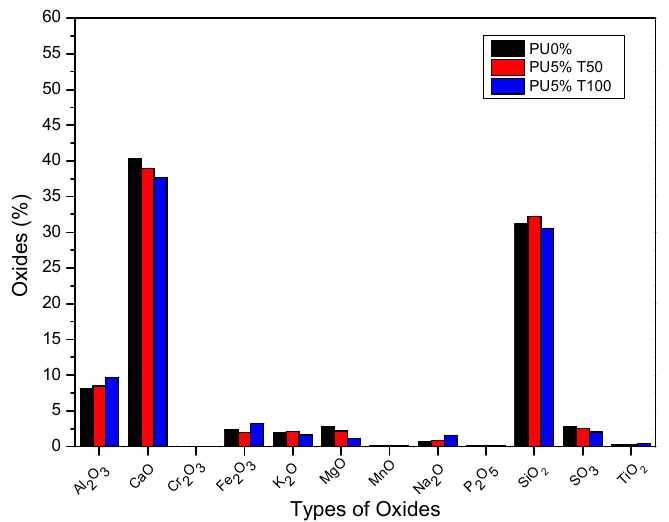
Figure 3. Percentages of different minerals in the cement of polyurea mortars with 5% addition of PU and the use of different sieves (T50 and T100).